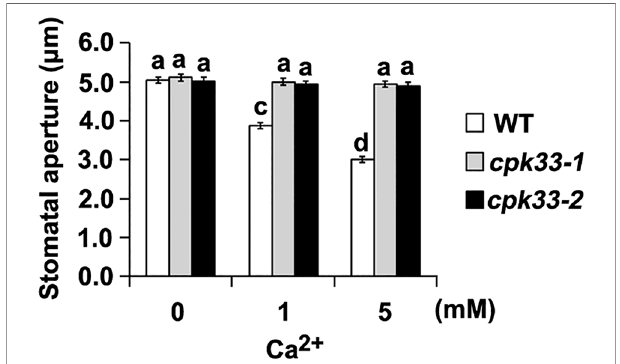
FIGURE 3 | Ca 2+ -induced stomatal closure is signi fi cantly impaired in cpk33 mutants. Leaves of WT plants, cpk33-1 , and cpk33-2 mutants with open stomata were exposed to the MES-KCl buffer containing different concentrations of CaCl 2 . Stomatal apertures were subsequently measured and presented as means ± SE of three independent experiments. Bars with different letters represent statistically signi fi cant differences.